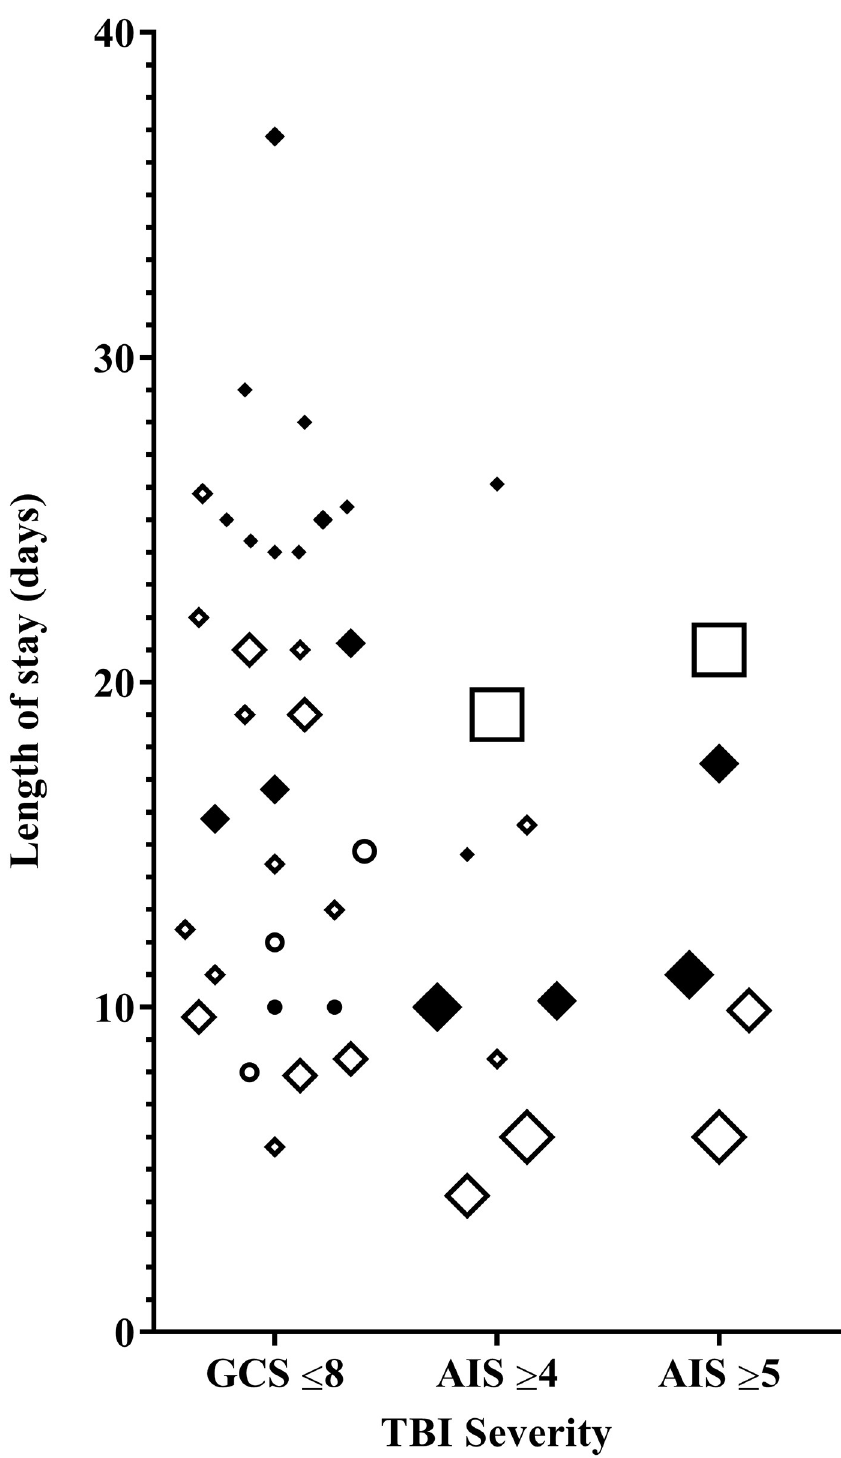
Fig 3. ICU and hospital length of stay of a patient with s-TBI. Black indicators represent hospital length of stay, while white indicators represent ICU length of stay. A bigger indicator size, represents a bigger study cohort size. ● � : Paediatric ♦ ^ : Adult ■ □ :